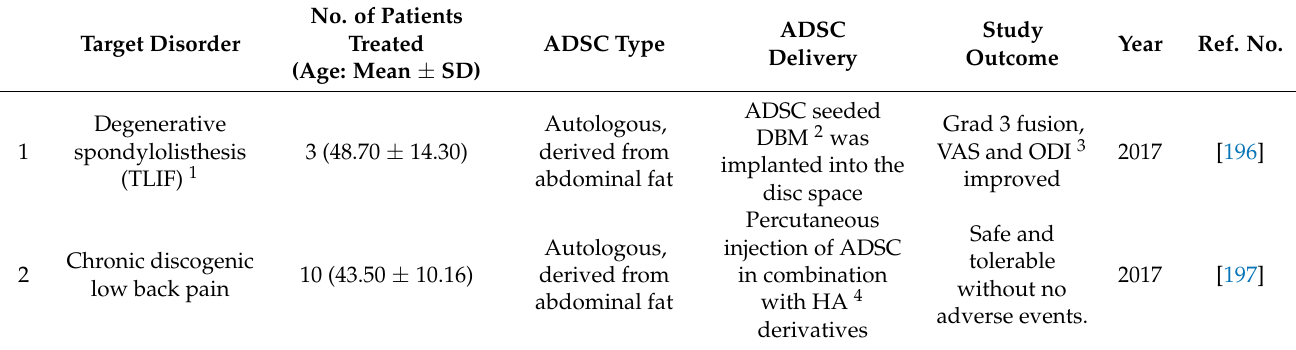
Table 4. Summary of clinical studies involving the use of isolated hADSCs on spine disorders for the last 10 years.